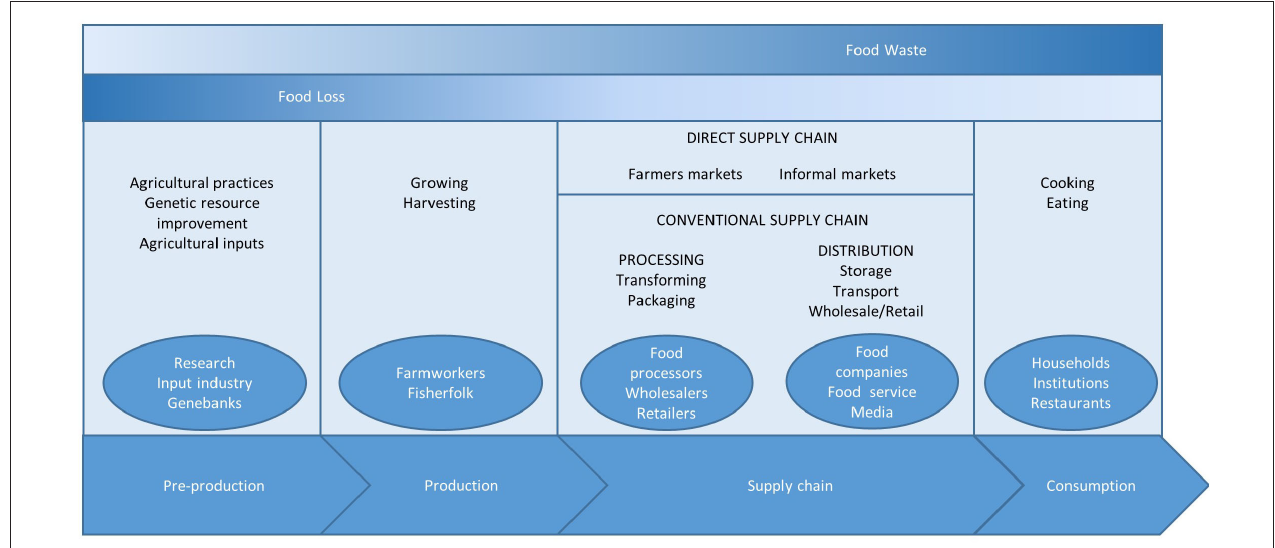
FIGURE 1 | The food system. Actors (in blue circles), activities and stages of the food system where food loss and food waste are created (based on CIAT,